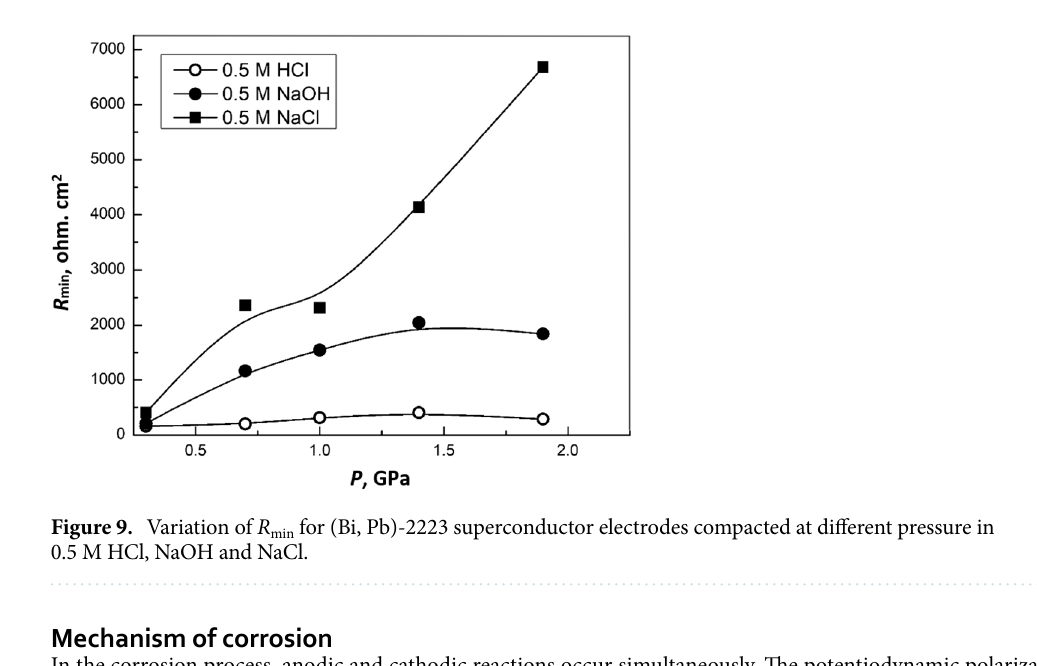
Figure 8. Bode impedance plots of (Bi, Pb)-2223 superconductor electrodes compacted at different pressure in 0.5 M HCl.